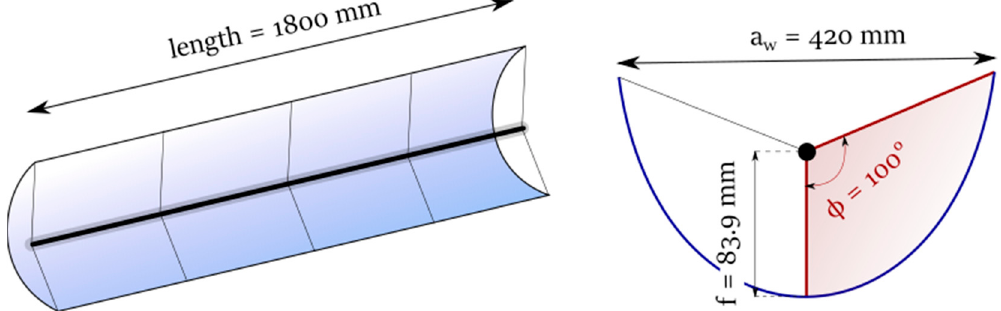
Figure 1. Simplified scheme of the micro-parabolic trough collector (m-PTC) designed by the University of Florence. Length, aperture width ( a w ), focal length ( f ), and rim-angle ( φ ) are